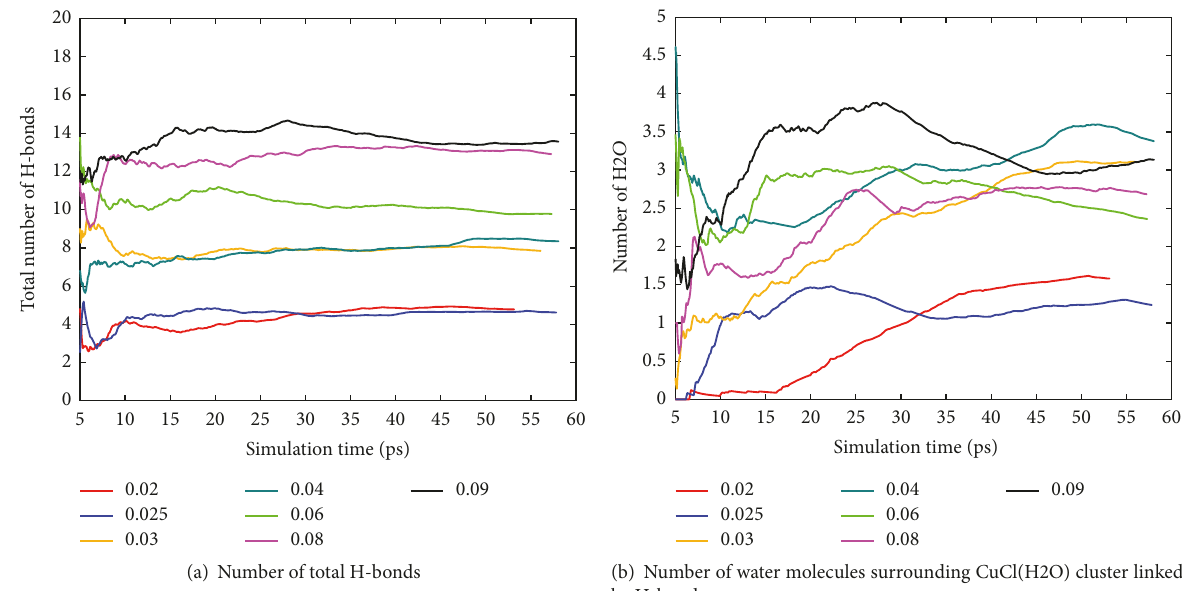
Figure 8: Running average for the total number of H-bonds (a) and number of water molecules surrounding the [CuCl(H 2 O)] 0 cluster linked by H-bonds (b) at different density.